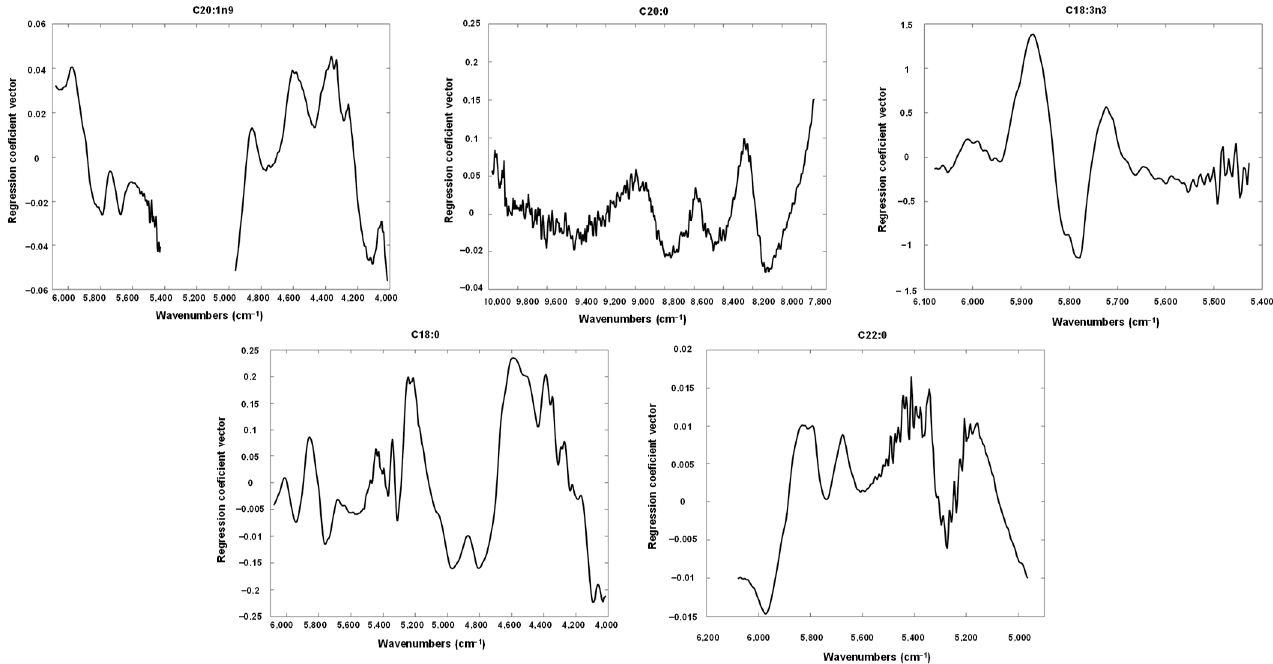
Figure 7. Regression coefficients vectors of the best PLS models built for fatty acids C20:1n9, C20:0, C18:3n, C18:0 and C22.